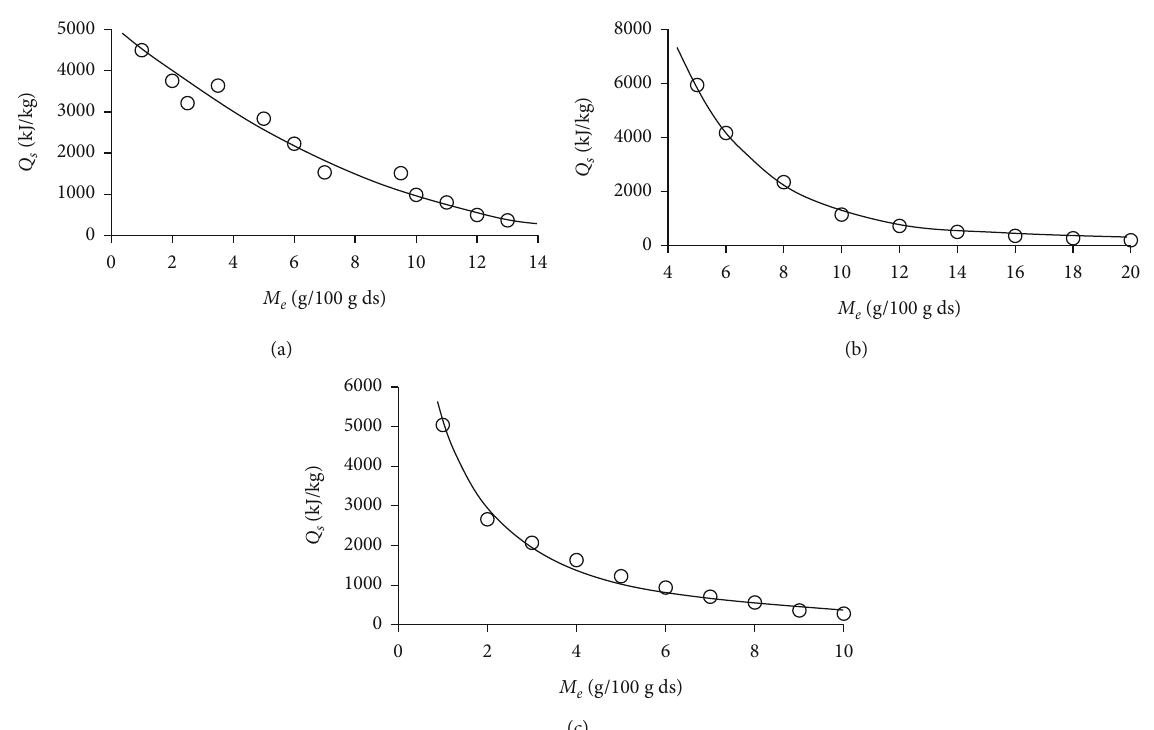
Figure 8: Isosteric heat of adsorption as a function of moisture content ((a) cellulose, (b) lignin, and (c)